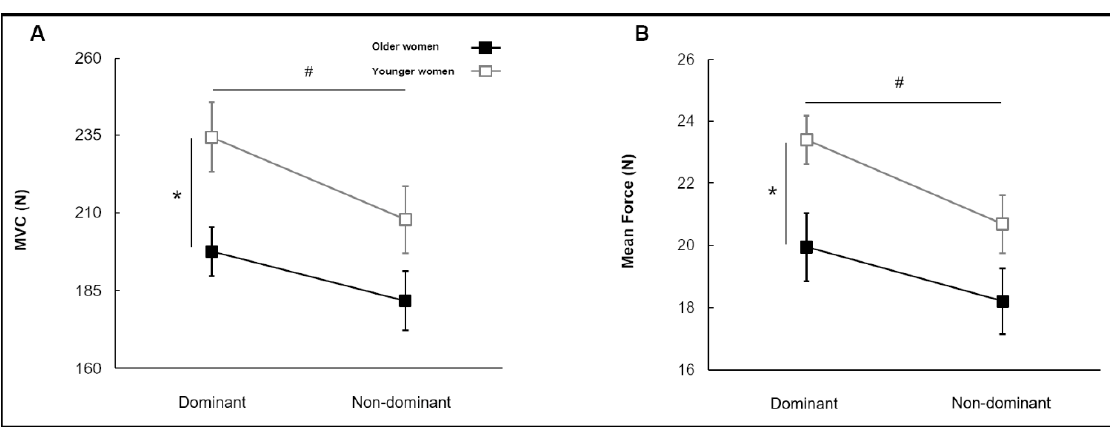
Figure 2: Maximum voluntary contraction and mean force for group and hand conditions ( M±SE ). ( A ) Maximal force (MVC) showing two main effects (i.e., Group and Hand Condition main effects). ( B ) Sub- maximal force production (mean force) showing two main effects (i.e., Group and Hand Condition main effect). Asterisk (*) indicates a significant difference between groups. Number sign (#) means a signifi- cant difference between hand conditions. ( P <